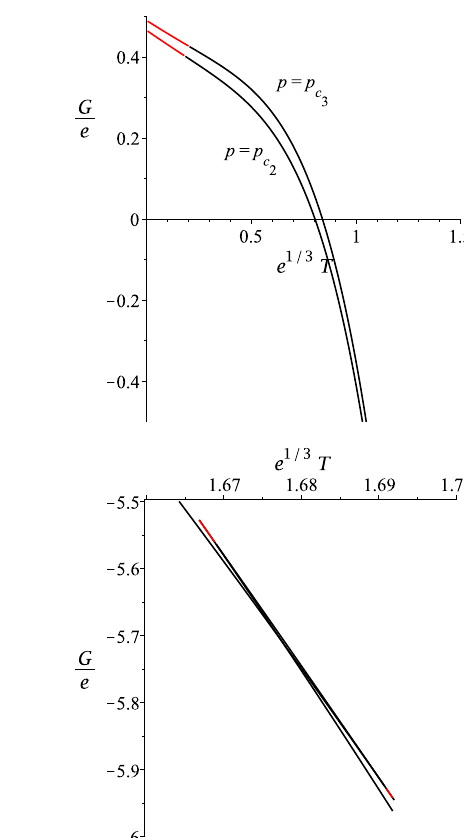
; P c (top right), for P = 2 3 (bottom right). The latter two cases exhibit 3 e 2 = 3 (cid:25) 0 : 03960, P c e 2 = 3 (cid:25) 0 : 33752 and 1 2